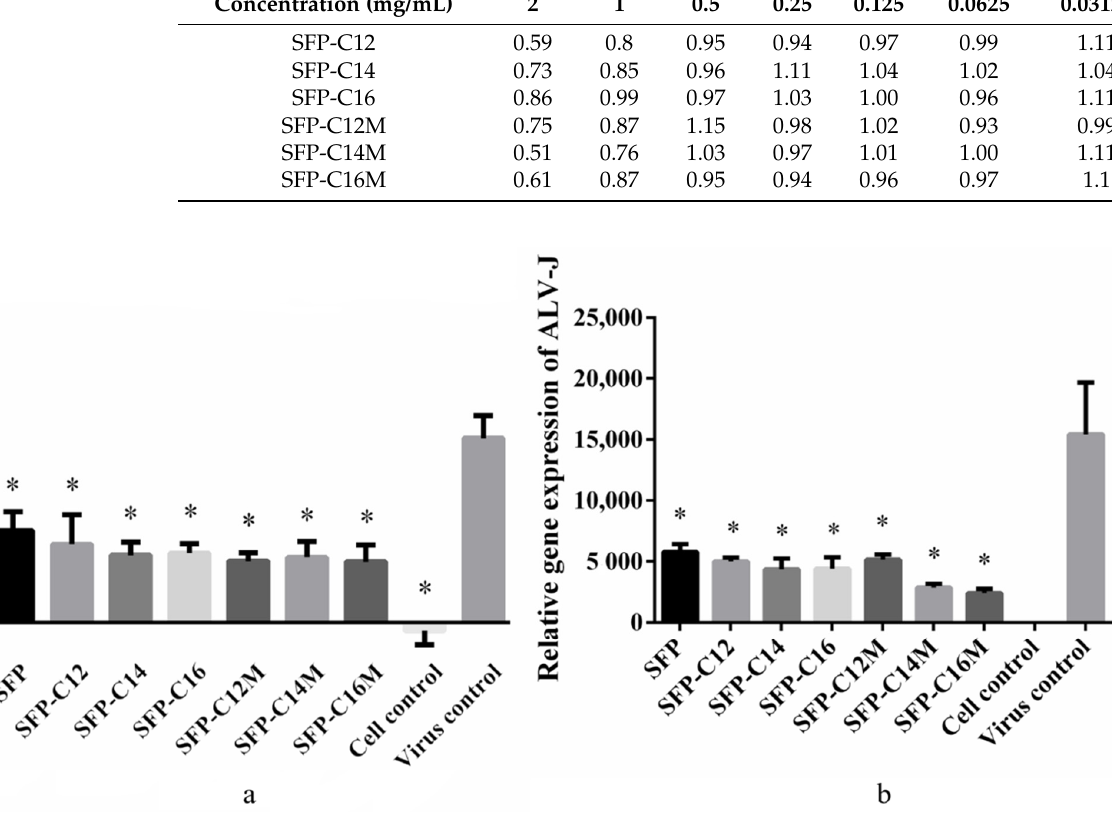
Figure 6. Antiviral effects of the SFP derivatives and nanomicelles. The results are the means + SD ( n = 3); * p < 0.05 compared with the virus control. ( a ) Relative ALV p27 antigen expression; ( b ) relative ALV-J gene expression.